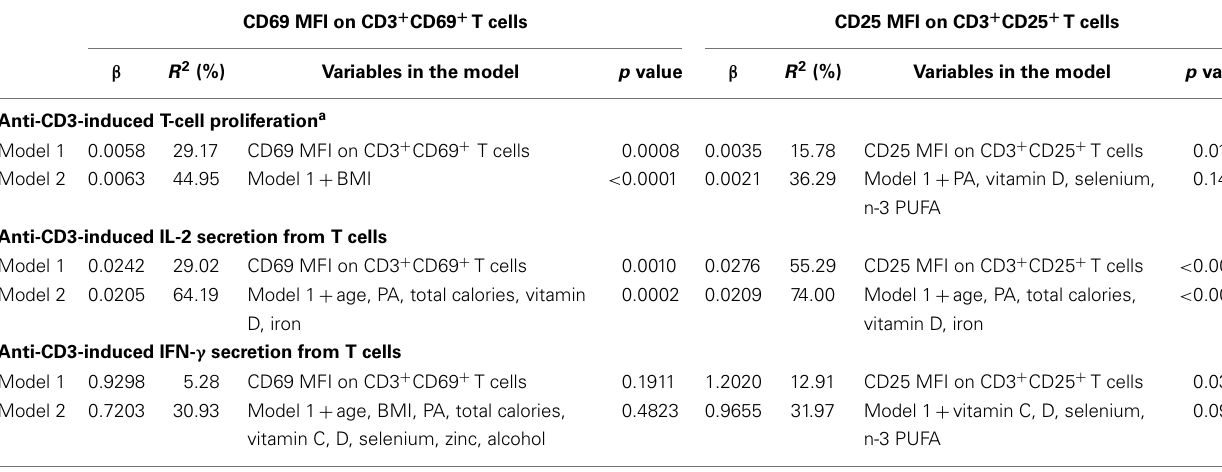
Table 3 |Activation marker expression on unstimulated T cells as predictors of T-cell effector function